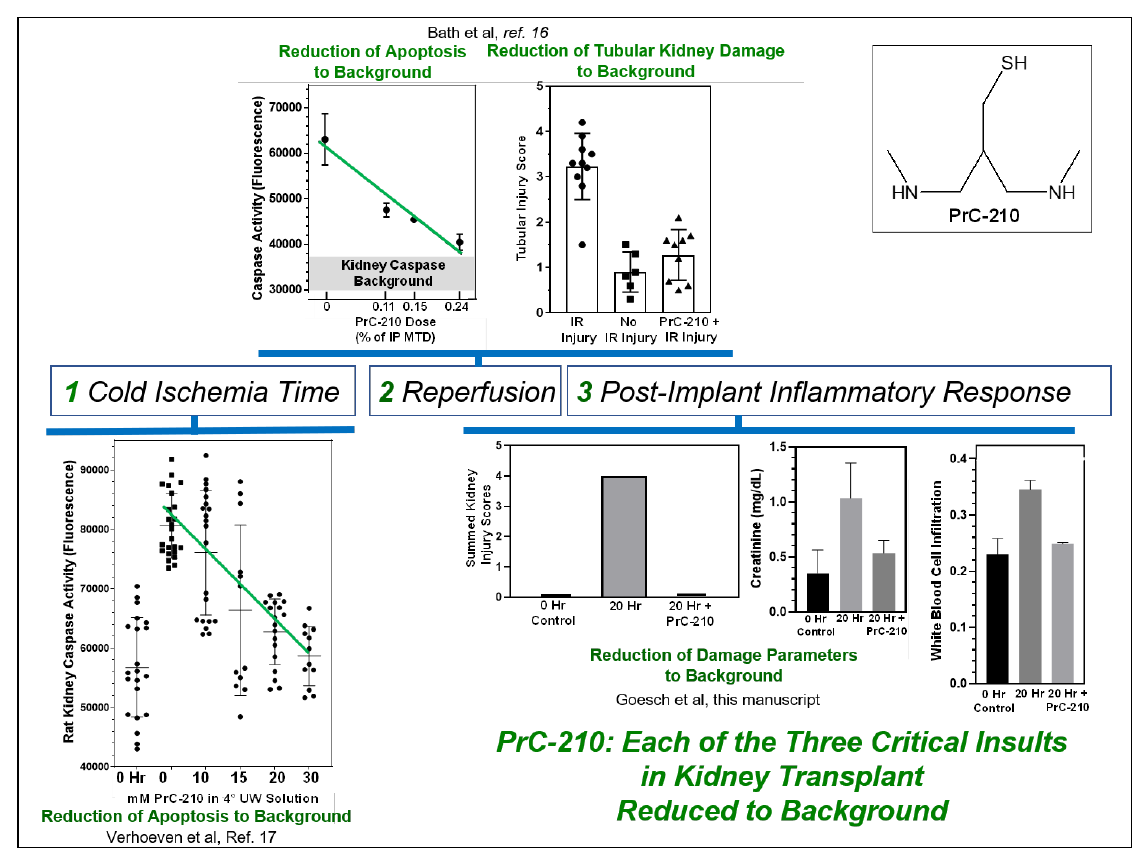
Figure 8. Schematic summarizing PrC-210 efficacy in suppressing each of the three organ insults that occur during kidney